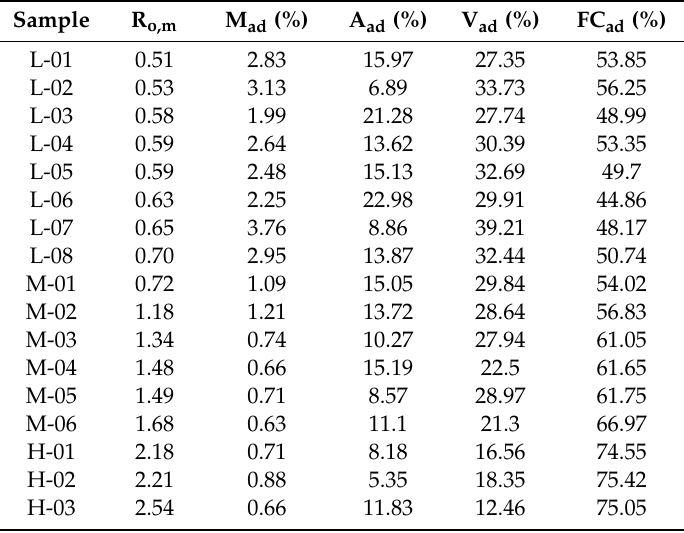
Table 1. Result of R o,m and proximate analysis of the coal samples.